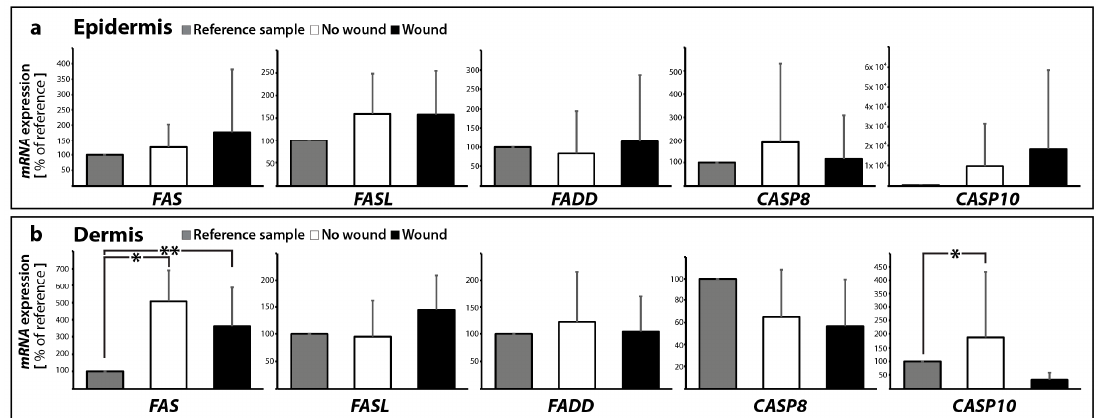
Figure 5. Quantitative real-time PCR of regulators of apoptosis: The mRNA expression levels are shown for reference control (0 day), non-wounded and wounded skin samples after ten days in organ culture medium. FAS , FASL , FADD , CASP8 , and CASP10 were investigated for epidermis ( a ) and dermis ( b ) respectively; * p < 0.05 reference vs. no wound, ** p < 0.05 reference vs. wound.